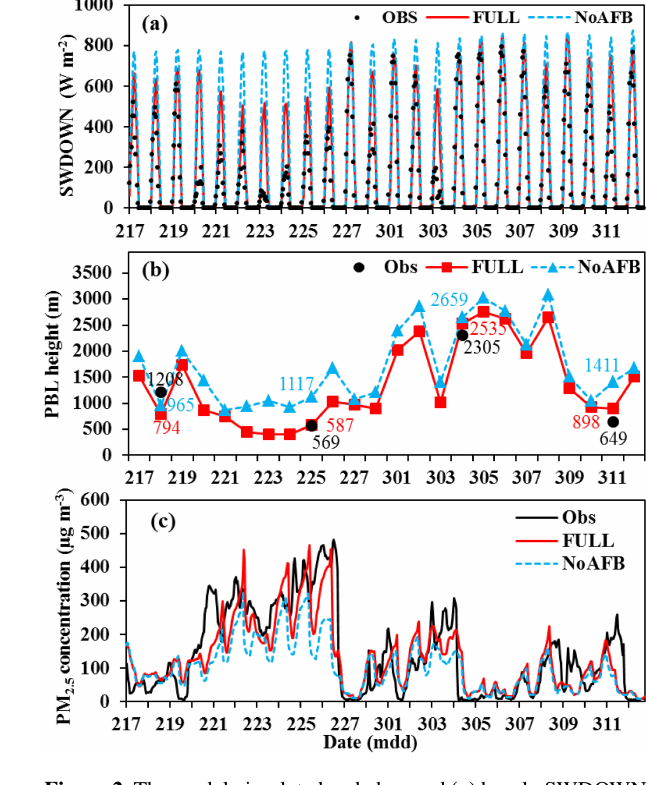
Figure 2. The model-simulated and observed (a) hourly SWDOWN at Xianghe, (b) hourly PBL height at 14:00LST at Xianghe (note that observations are available in 4d; numbers are observations and corresponding simulations), and (c) hourly PM 2 . 5 concentration at IAP site in Beijing.